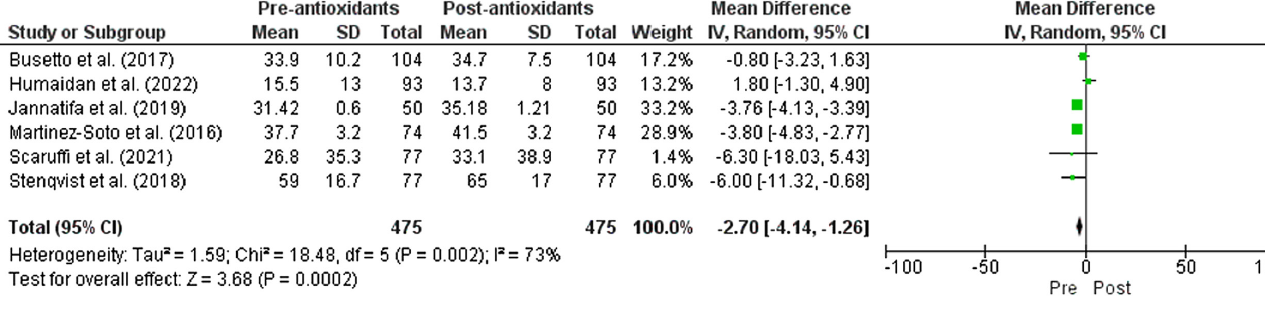
Figure 5. A forest plot showing total sperm motility.